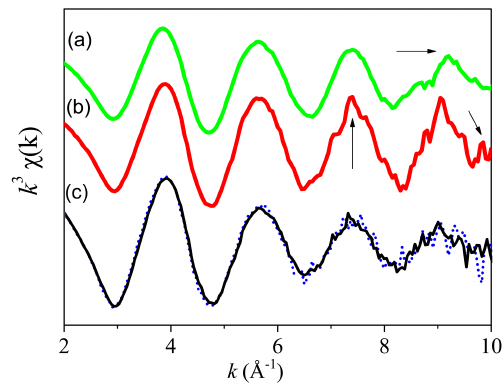
Figure 5. Normalized Cd K-edge k 3 -weighted EXAFS spectra of B. subtilis (a) , montmorillonite (b) , and montmorillonite– B. sub- tilis composite (c) at pH6. Dotted (blue) line displays the best two- component linear combination